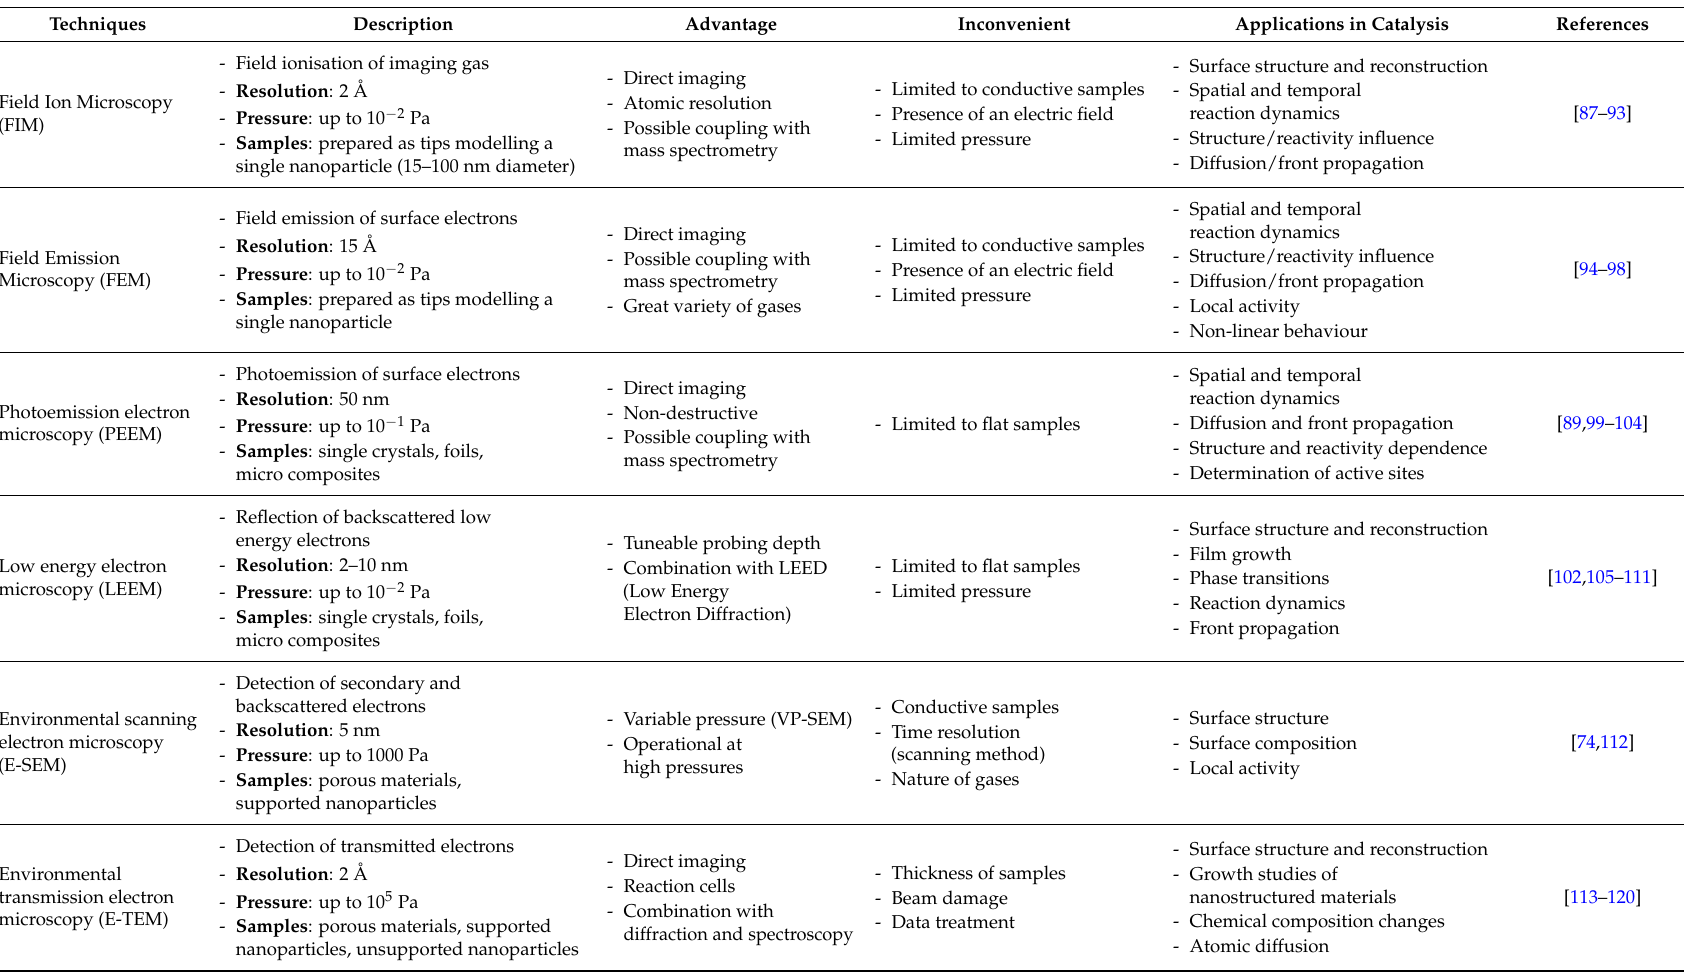
Table 1. General description of the main relevant environmental microscopy techniques used for catalysis applications, together with their advantages, inconvenient, and domains of applications in